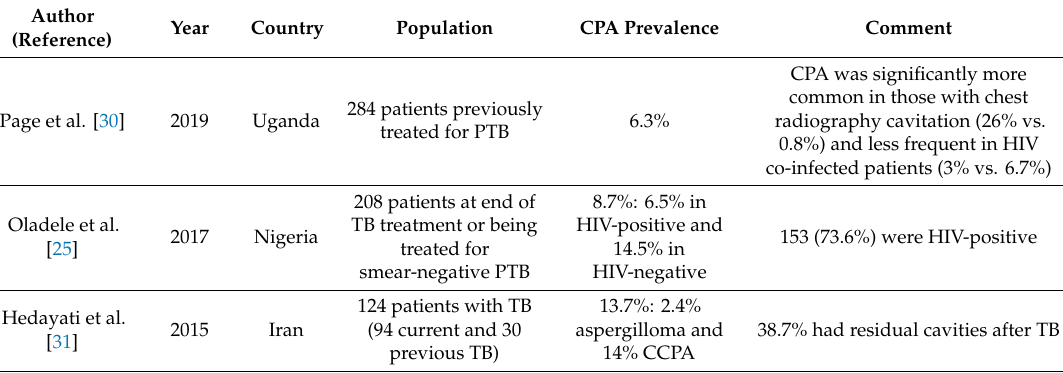
Table 1. Findings of epidemiological studies on chronic pulmonary